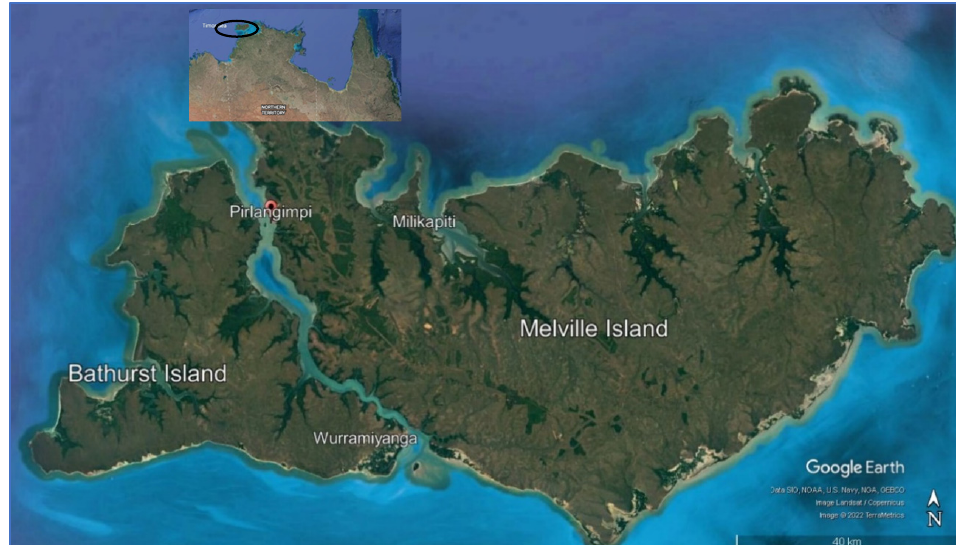
Figure 1. Map of the Tiwi Islands with an inset map of Northern Australia.